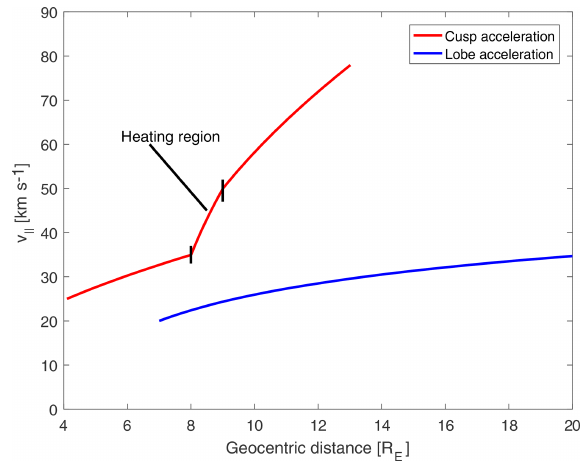
Figure 4. Velocity dependence on radial distance in cusps and lobes, using acceleration values given in the text. The red line rep- resents cusp velocities and the blue line represents lobe